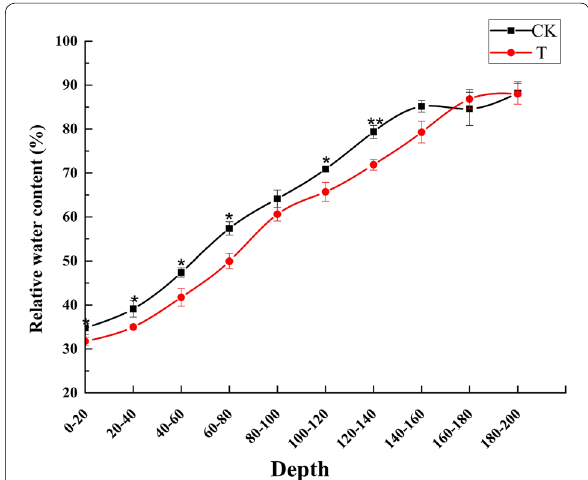
Fig. 1 Soil relative water content at 20 DPA. Soil relative water content was measured at 2 m depth of soil in the control (CK) and drought treatment (T) groups. Statistically significant differences compared to the control were calculated based on an independent Student’s t-tests. Asterisks indicate significant different (*p < 0.05; **p < 0.01). Error bars indicate standard errors of three